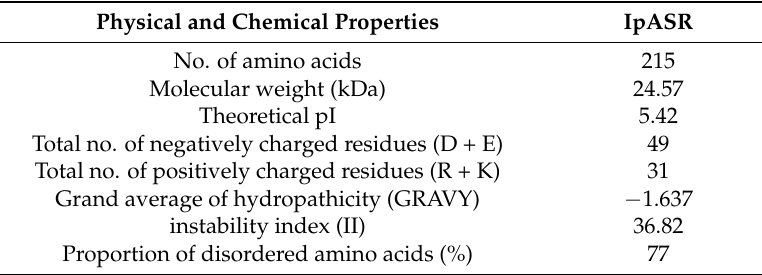
Table 1. The physical and chemical properties of the IpASR